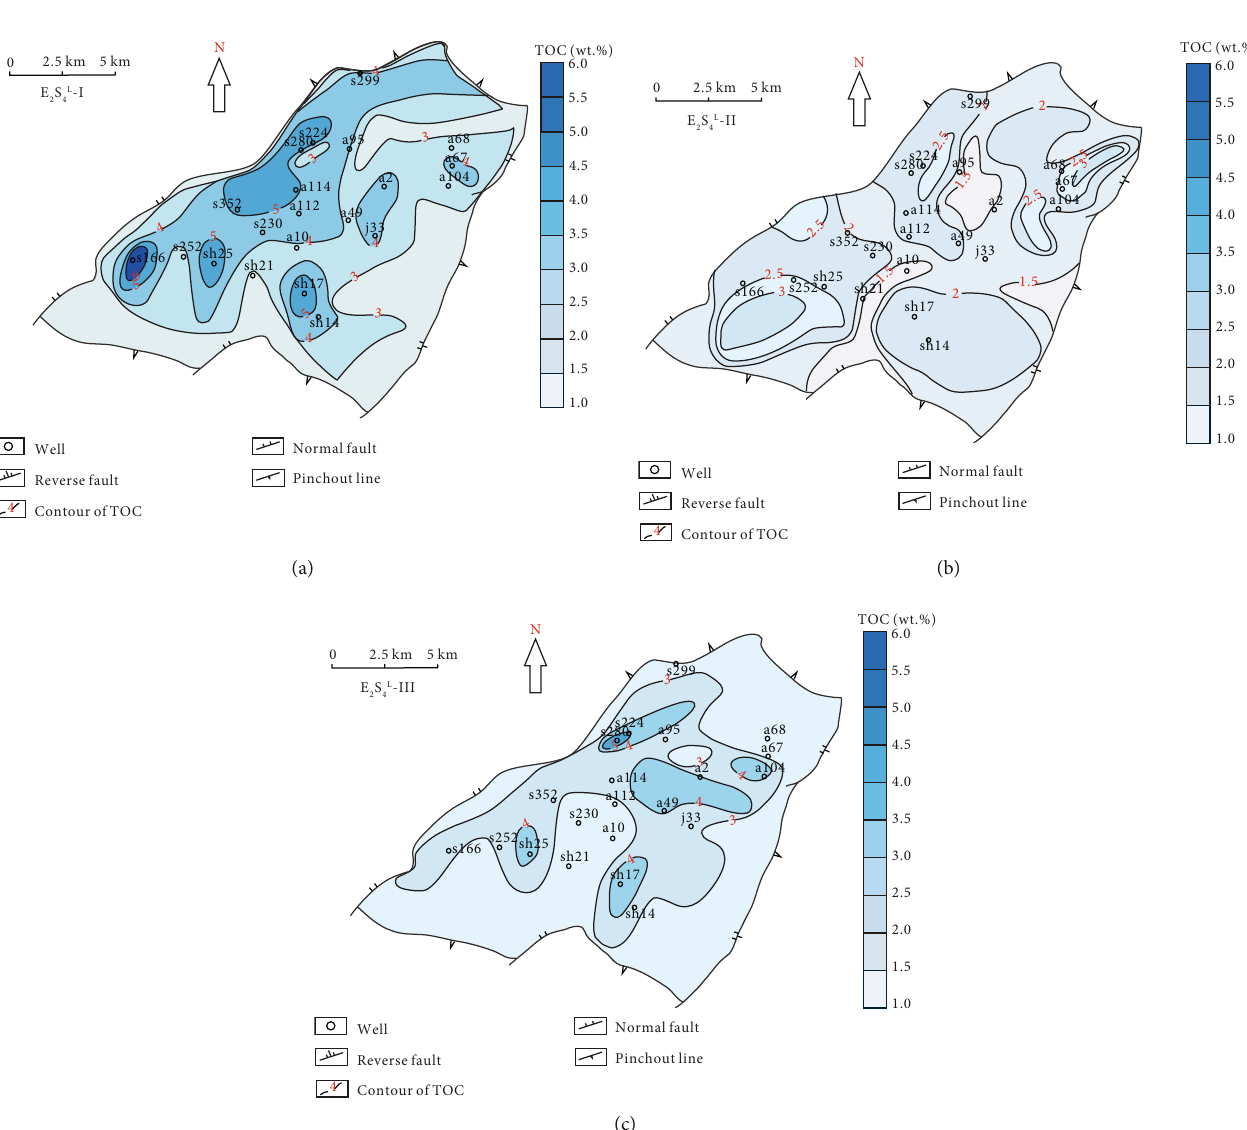
s 4L -I group, (b) E 2